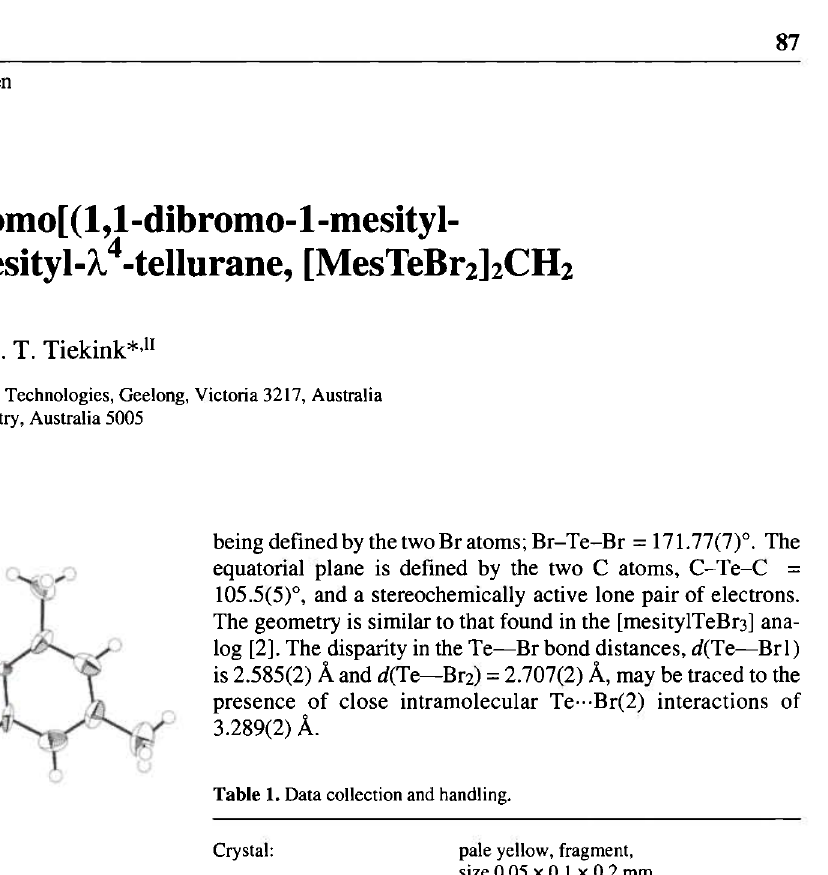
Table 1. Data collection and handling.